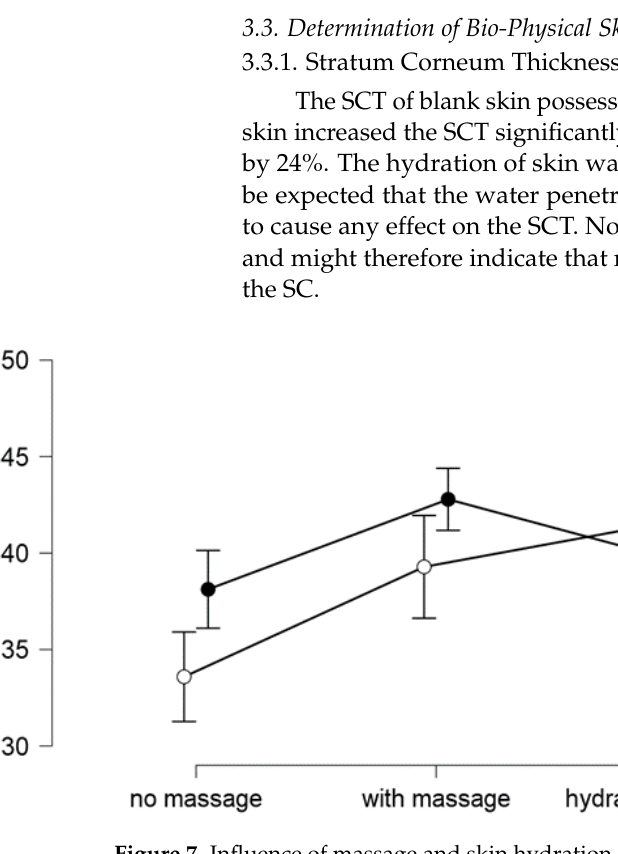
Figure 6. Dermal penetration efficacy of Nile red when loaded into Vaseline and applied onto skin without massage, with massage, and with massage on pre-hydrated skin. ( A ) ART-value (ART, MGV/px), a semi-quantitative parameter that estimates the amount of penetrated NR; ( B ) Mean penetration depth (MPD, µm).